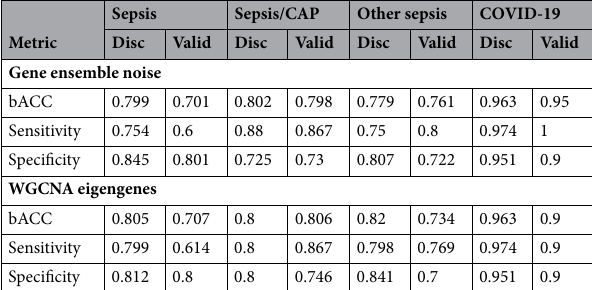
Table 2. Prediction accuracy of the models for the sepsis and COVID-19 patients based on the gene ensemble noise and WGCNA eigengenes explanatory variables for the discovery (Disc.) and validation (Valid.) cohorts.